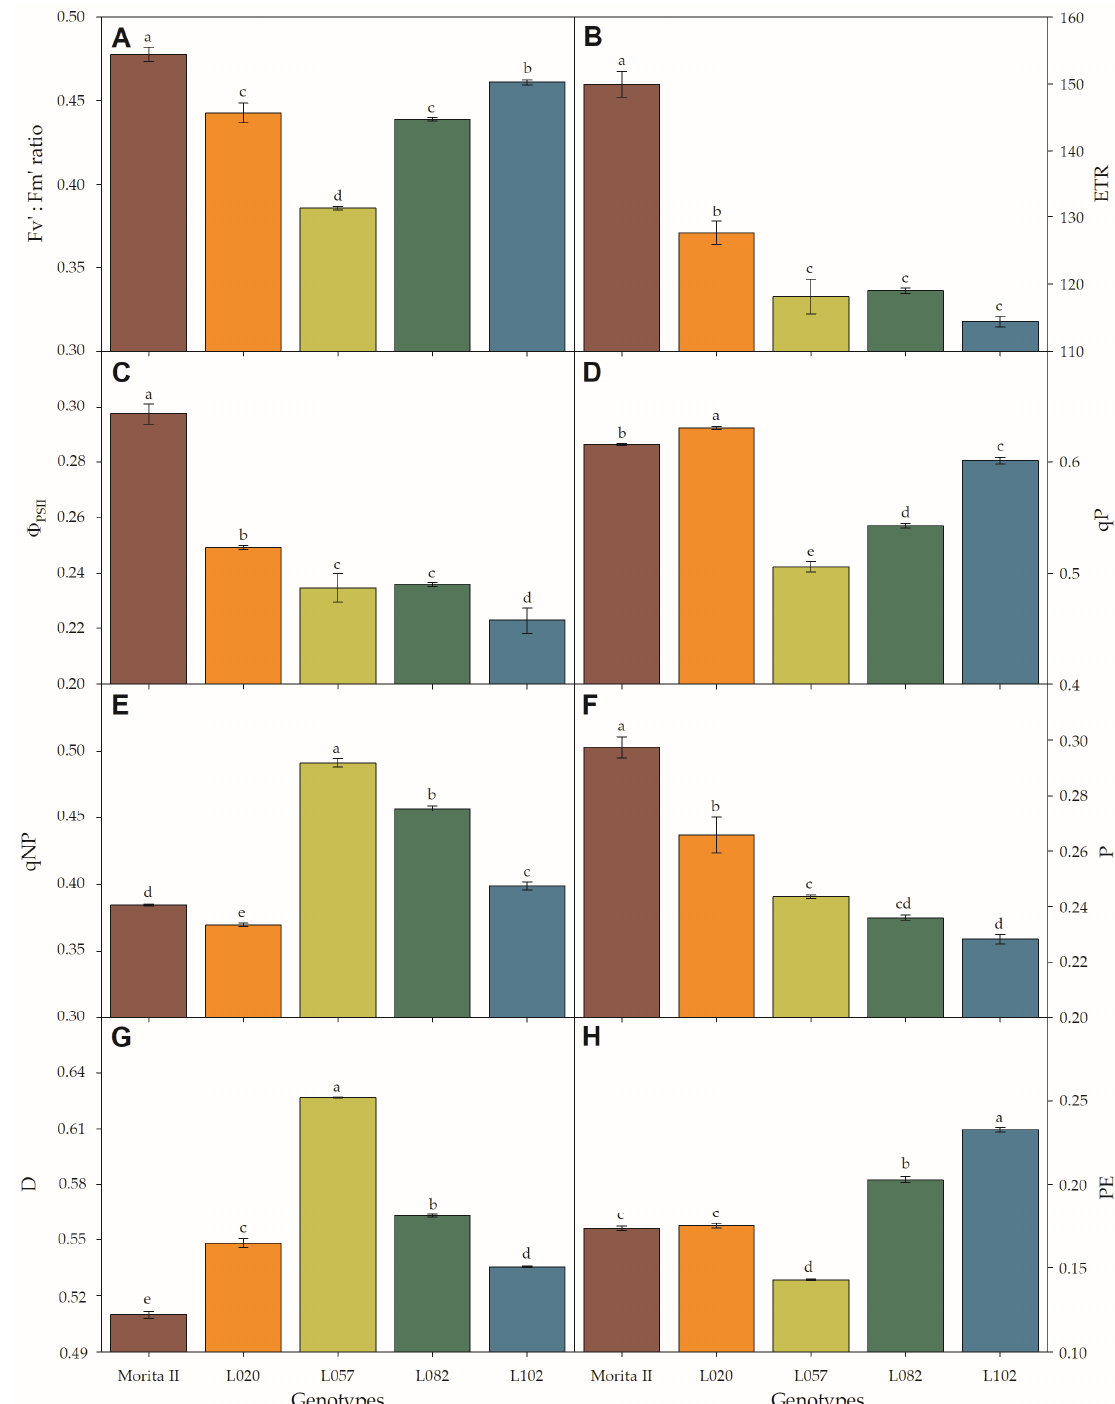
Figure 5. Light adapted variable-to-maximum (Fv’:Fm’ ratio) chlorophyll fluorescence ( A ), electron transport rate (ETR; ( B )), quantum yield of photosystem II ( Φ PSII ; ( C )), photochemical quenching (qP; ( D )), non-photochemical quenching (qNP; ( E )), fractions of absorbed photosynthetic active radiation used in photochemistry (P; ( F )) or dissipated as heat (D; ( G )), and the fraction neither used in photochemistry nor dissipated thermally (PE; ( H )) evaluated in genotypes of Stevia rebaudiana (Morita II, L020, L057, L082, and L102) under land conditions in the complete absence of any plant stress. In each feature, means followed by different letters denote statistical significance ( p < 0.001). Means ± SD (n =